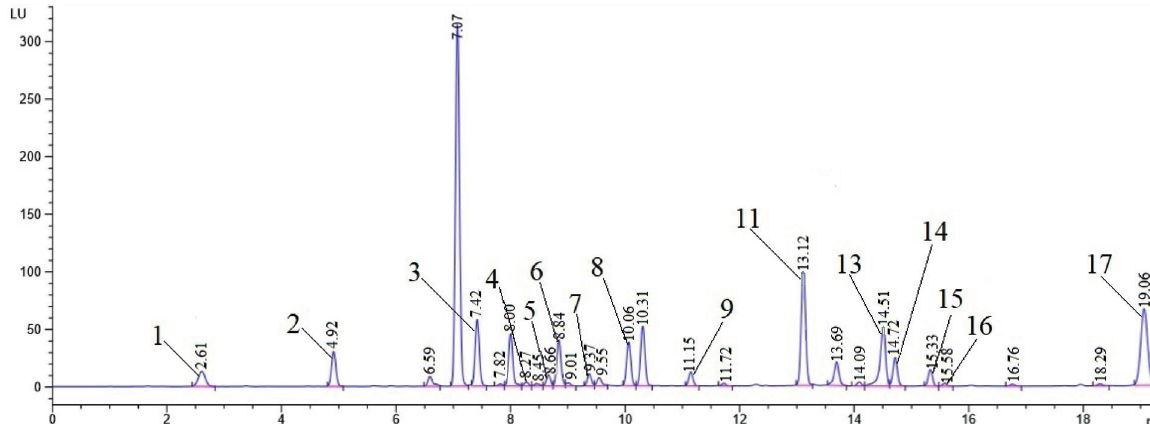
Figure 1. HPLC chromatogram of free amino acids of Stahys sieboldii herb.